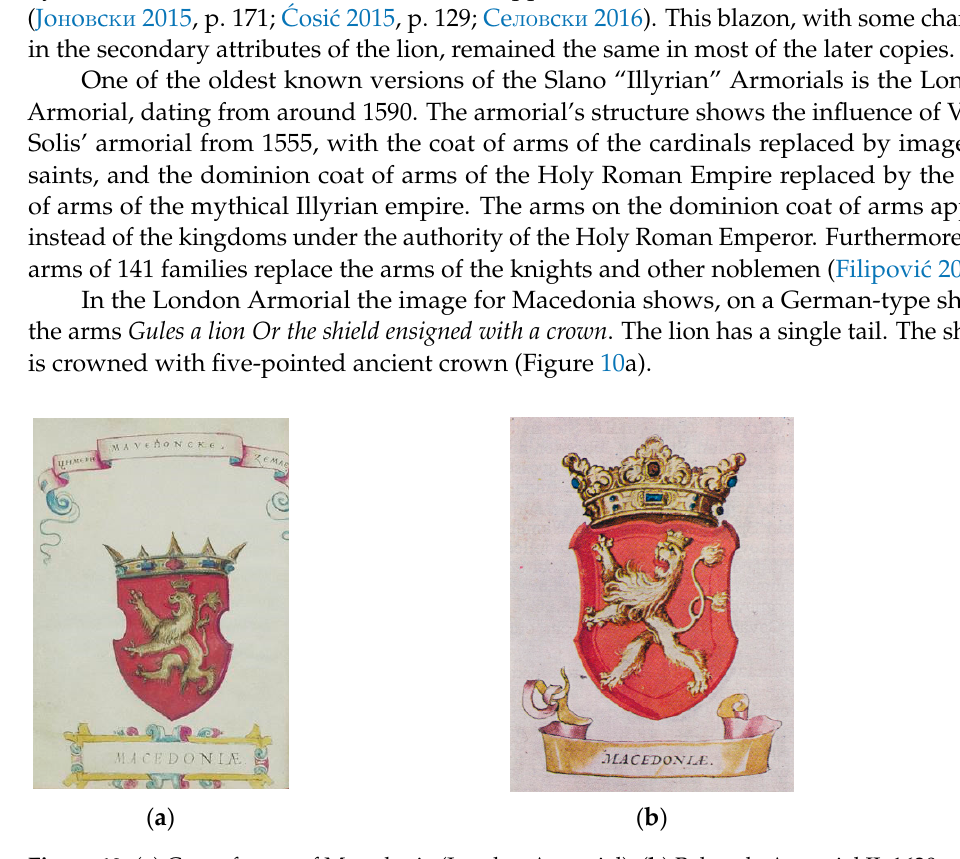
Figure 10. ( a ) Coat of arms of Macedonia (London Armorial); ( b ) Belgrade Armorial II, 1620. Very similar to the London Armorial is the armorial of Korenic-Neoric, held by the University Library in Zagreb, and believed to date from 1595. The Macedonian coat of arms is shown three times: as the 1st (top dexter) field of the dominion coats of arms of King Stefan Nemanjic, those of King Urosh, and on a separate page. Only the lion in this armorial is armed Or . This armorial, unlike the London Armorial, also includes the arms of Spanish families into which the Korenic–Neoric daughters and other female descendants would marry after there were no male descendants ( ´Cosi´c 2015, pp.